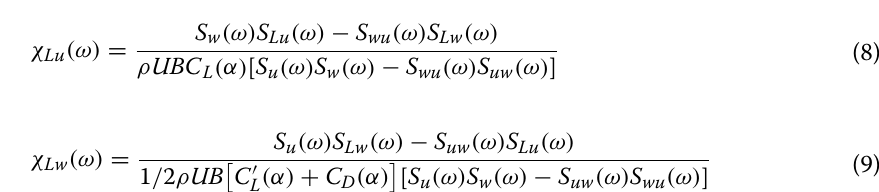
where L , D, and M represent lift, drag, and torque components of the buffeting aerody- namic force per unit length, and show the relevant parameters of the aerodynamic items; ρ and U represent air density and inflow wind velocity, respectively; B is the bridge girder width; C is the static wind coefficient; C ′ is the derivative of static wind coefficient with respect to inflow angle of attack (AOA); χ is the aerodynamic admittance function; and u and w are the horizontal and vertical components of the fluctuating wind velocity, respectively. As subscripts, u and w are related to the wind component. For simplicity, the analytical Sears function derived from the thin-plate or streamlined foil is usually used as the admittance function for a streamlined bridge deck (Diana et al., 2002; Zhao et al., 2020).